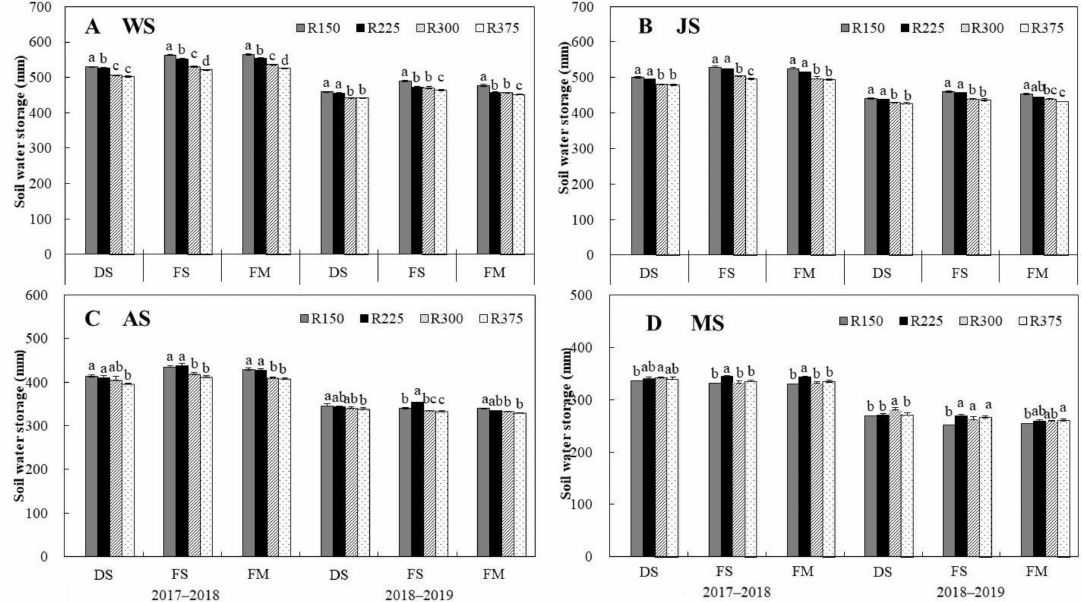
Figure 2. Effect of planting patterns and seeding rate on soil water storage (SWS) at different growth stages. overwintering stage, WS; jointing stage, JS; anthesis stages, AS; mature stage, MS. Different small letters indicate that means within a column are significantly different ( p ≤